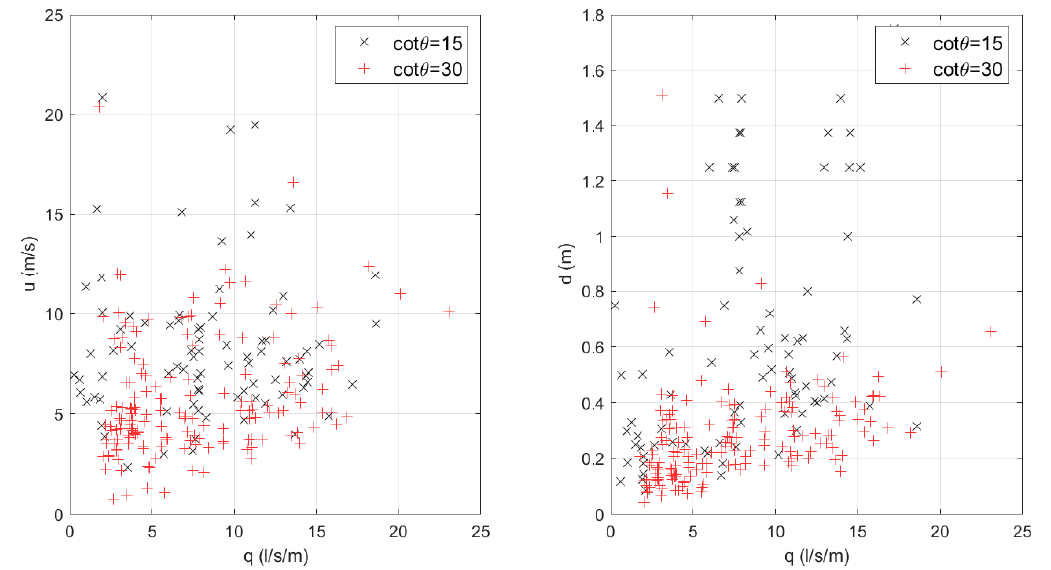
Figure 11. Variation of overtopping flow velocity and depth with maximum individual overtopping volume (dimensions in prototype) for two different foreshore slopes.